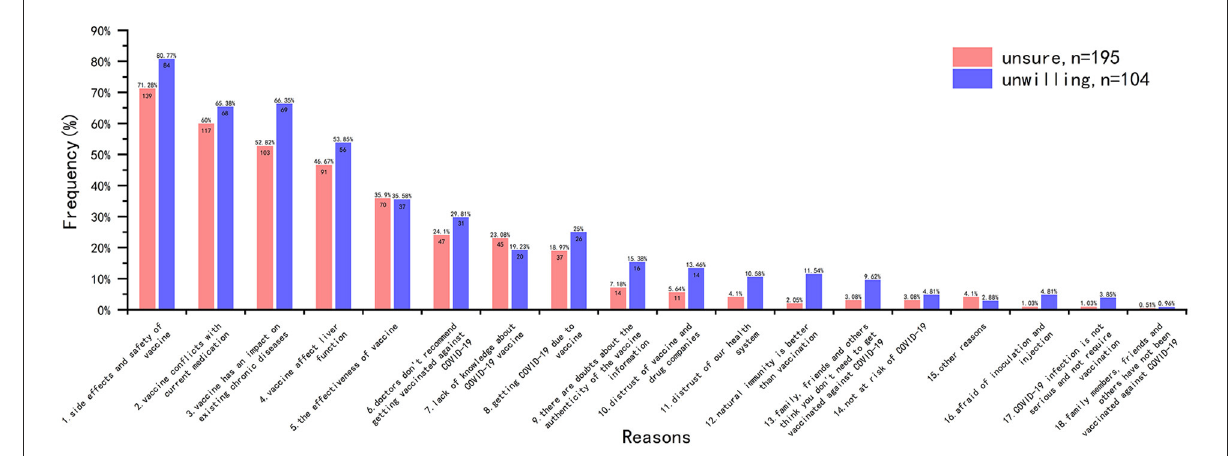
FIGURE5 Reasons for vaccination hesitancy.